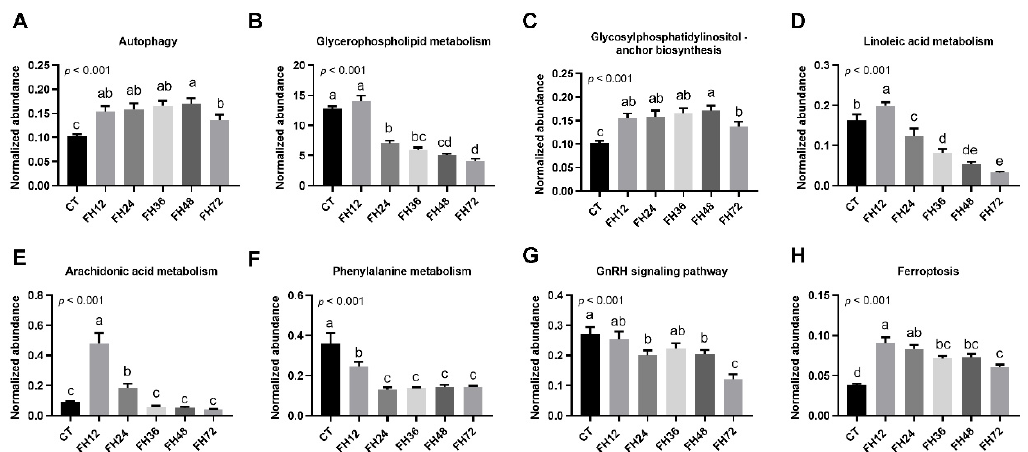
Figure 9. Effects of food withdrawal on the serum metabolome. ( A – H ) The normalized abundance of metabolite pathways from the control and fasting groups. Data are analyzed by ANOVA and multiple comparisons using the Duncan correction. Values are means ± SEM, n = 8. Labeled means without a common letter are significantly different, p ≤ 0.05. CT—birds fed ad libitum; FH12—birds fasted for 12 h; FH24—birds fasted for 24 h; FH36—birds fasted for 36 h; FH48—birds fasted for 48 h.